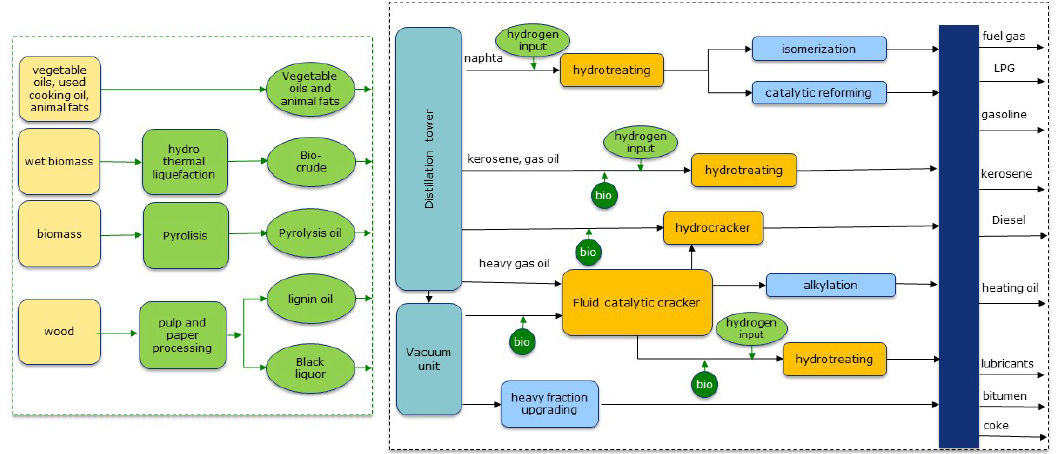
Figure 1. Overview of possible co-processing pathways.